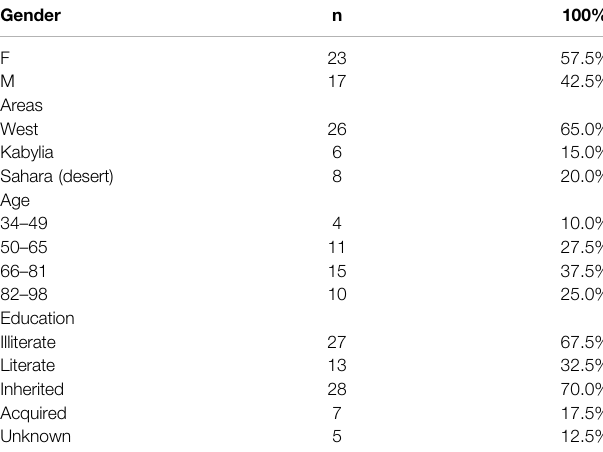
TABLE 1 | Demographic characteristics of the traditional healers.